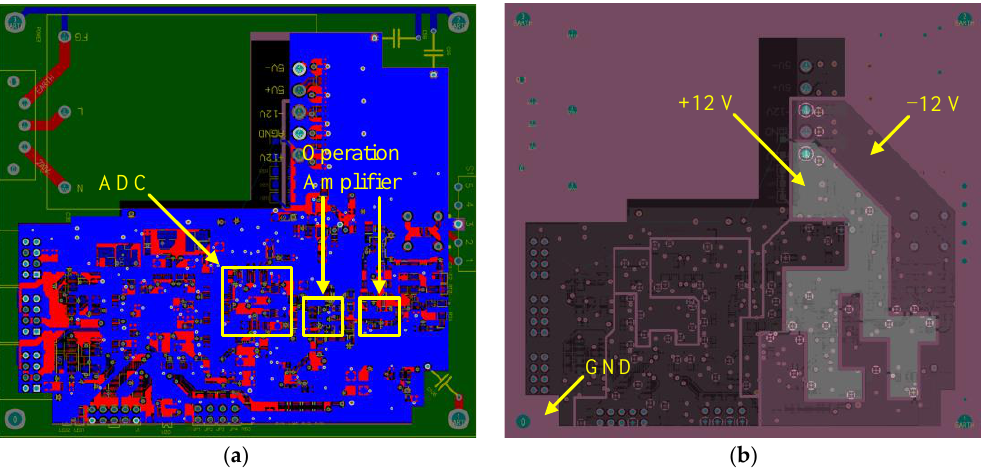
Figure 15. Acquisition card’s PCB key components and circuit location: ( a ) GND copper and chip locations on the top and bottom layers. ( b ) ±12 V copper on the VCC layer.